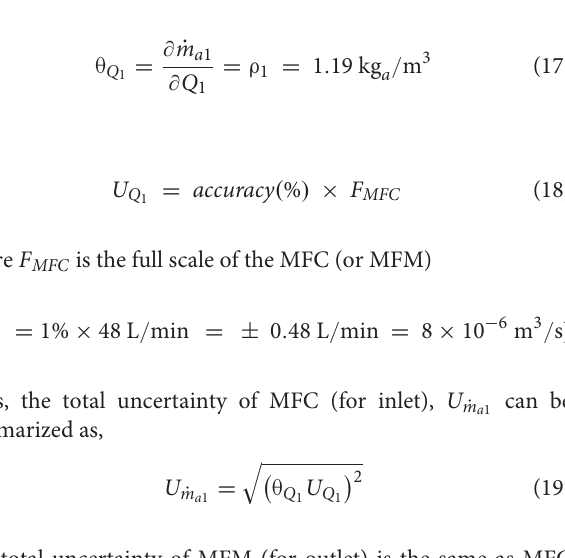
sufficient for stabilization purposes after 5 τ (70 s) of system operation. Therefore, after 70 s, the valves were turned on, and aerosols were directed into manifold